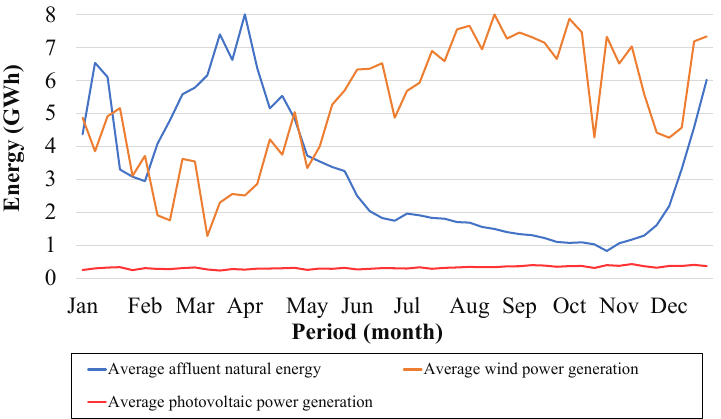
Figure 1. Comparison among average affluent natural energy, average wind power generation, and average photovoltaic power generation in 2019. Data source: [27].